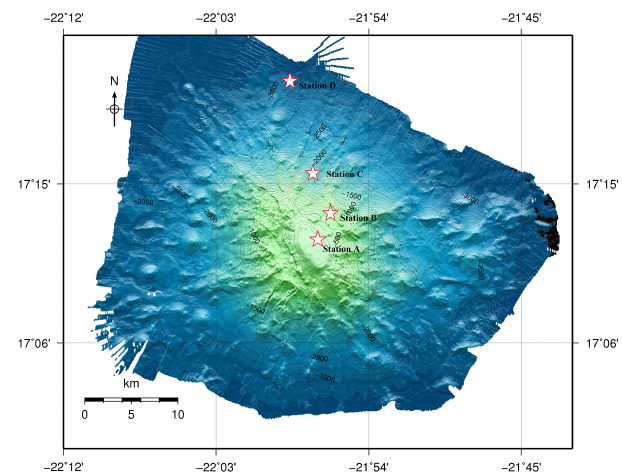
Fig. 1b. Senghor Seamount with the locations of the four sta- tions on the northern transect minus the reference station (summit plateau depth ∼ 130m, base depth ∼ 3200–3300m). Adapted by A. Chivers, original data and map created by Thor Hansteen and Alexander Schmidt,